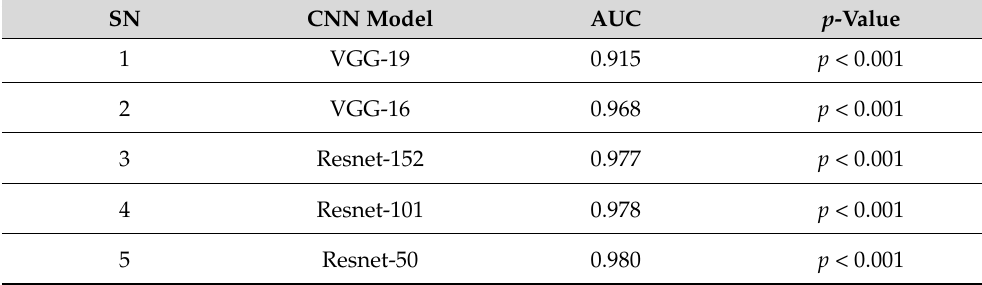
Table 4. AUC and p -value for the CNN